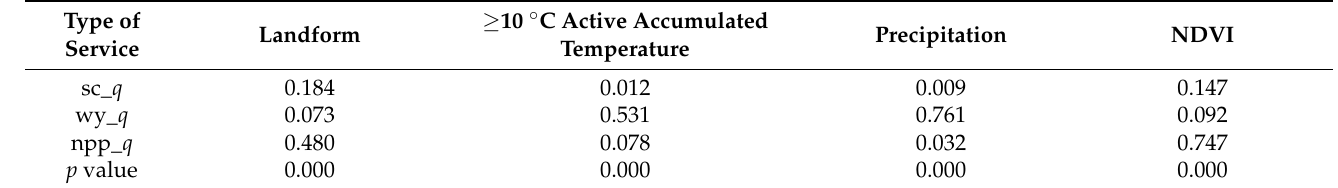
Figure 6. Influencing factors: ( a ) landform; ( b ) ≥ 10 ◦ C active accumulated temperature; ( c ) precipita- Figure 6. In fl uencing factors: ( a ) landform; ( b ) ≥ 10 °C active accumulated temperature; ( c ) precipi- tion; ( d ) NDVI. tation; ( d ) NDVI. Table 6. Q statistics of spatially divergent impact factors of Ecosystem